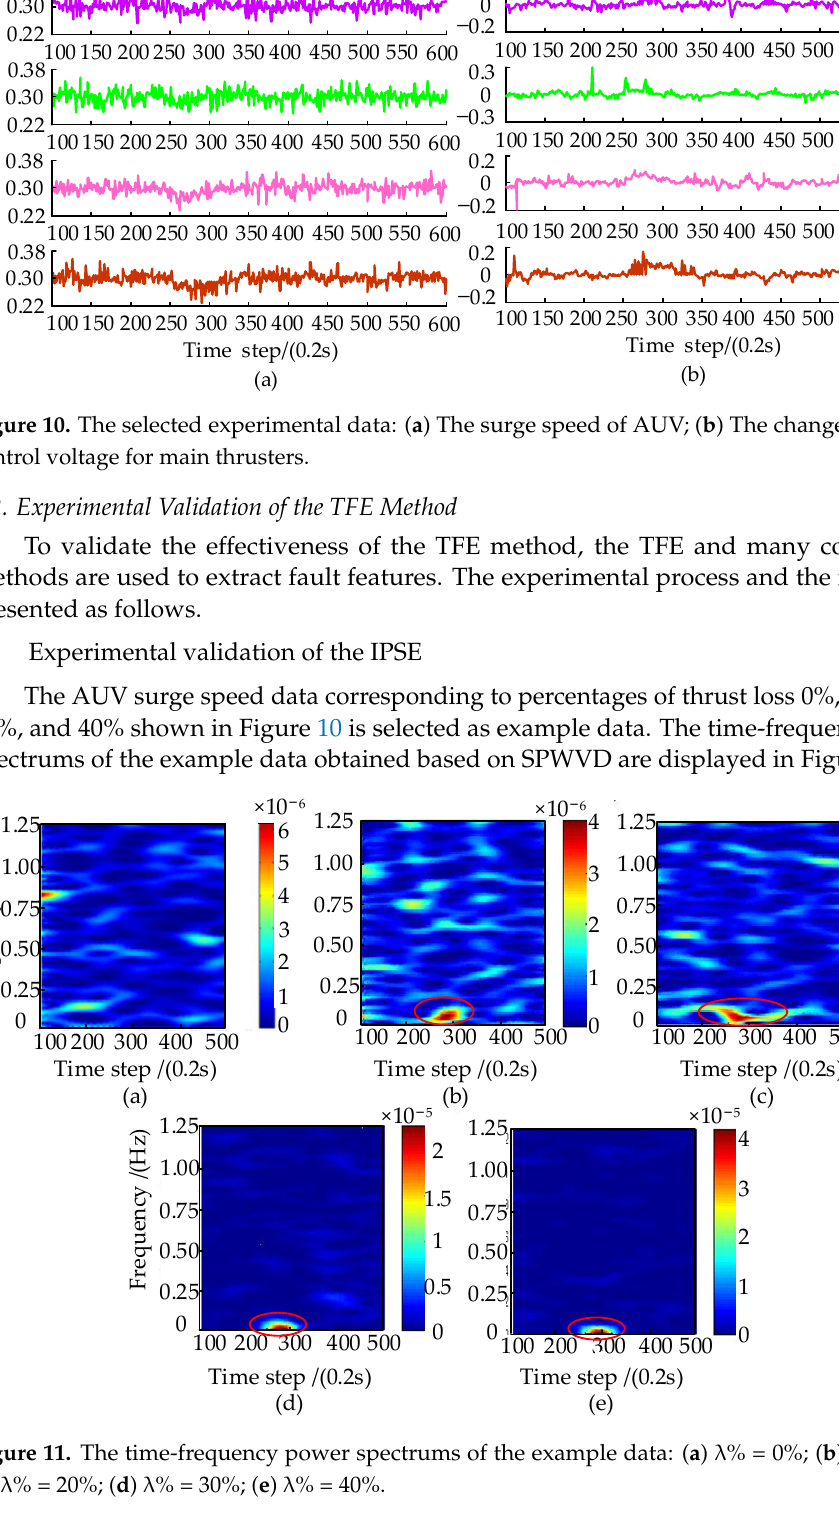
Figure 11. The time-frequency power spectrums of the example data: ( a ) λ % = 0%; ( b ) λ % = 10%; ( c ) λ % = 20%; ( d ) λ % = 30%; ( e ) λ % = 40%.